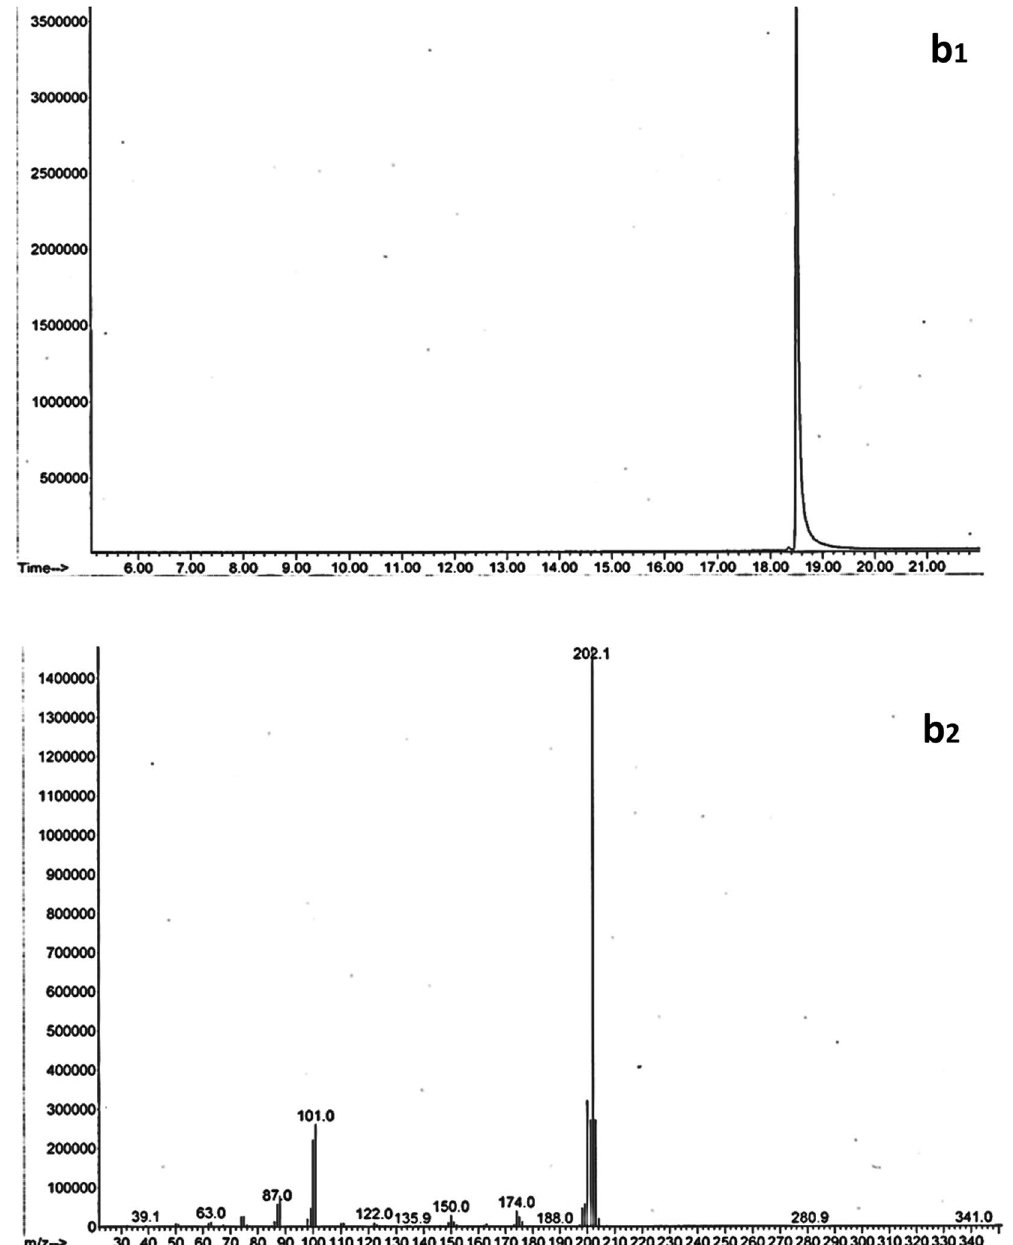
Figure 3. GC Chromatogram ( b1 ) and mass spectra ( b2 ) of